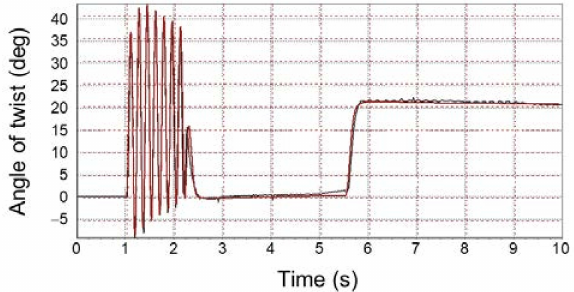
Figure 3. Comparison of the results of simulation tests (brown line) and experimental tests (black line) for the angle of the shaft twist